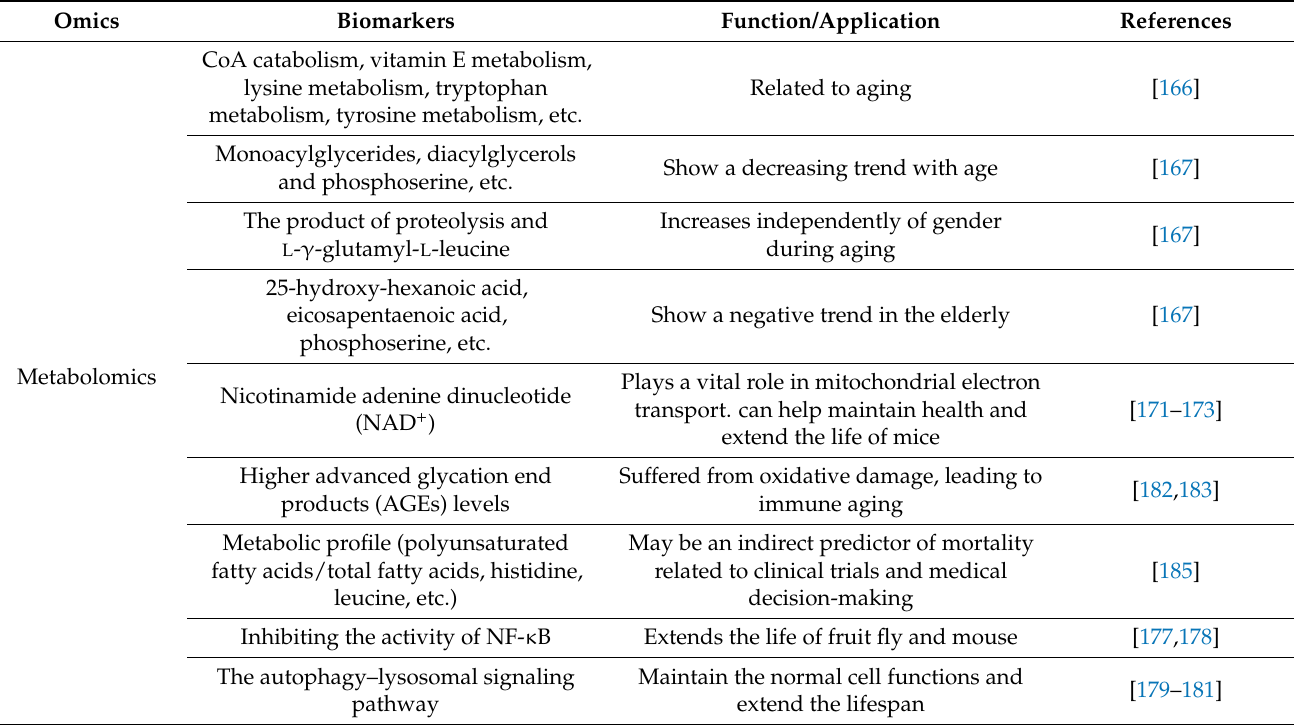
Table 4. Potential aging biomarkers identified in metabolomics